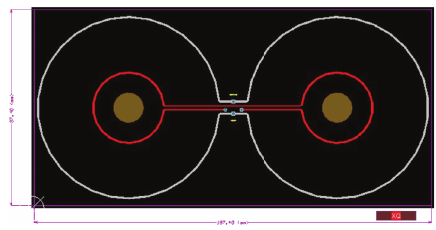
Figure 4: The PCB layout design of DTC